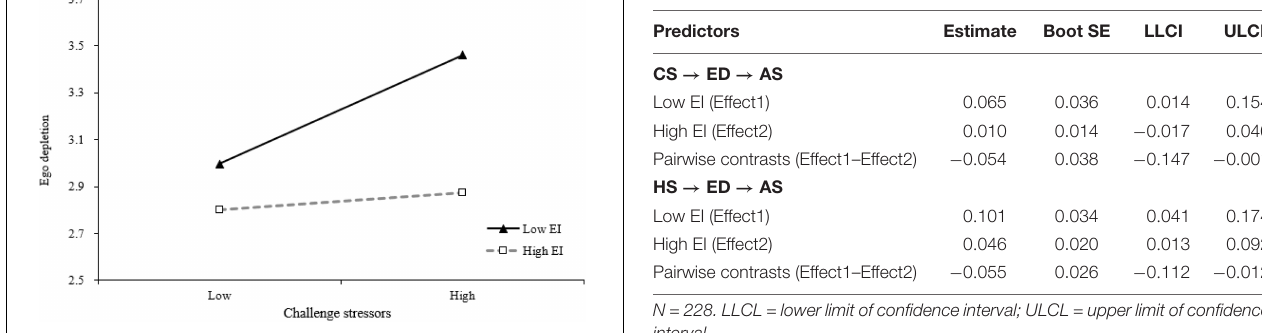
TABLE 4 | Indirect effect estimates with 95% confidence